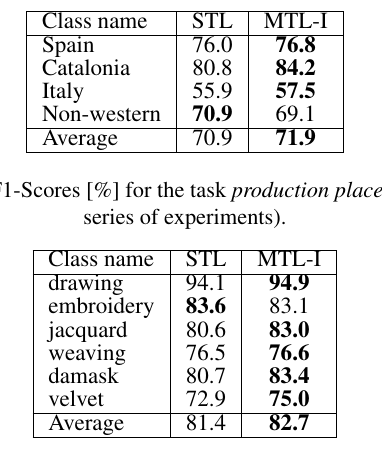
Table 9. F1-Scores [%] for the task technique (second series of